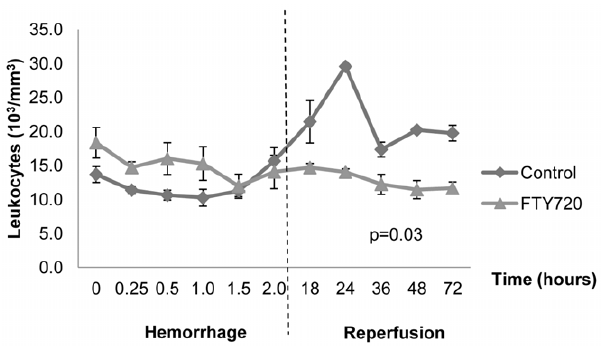
Figure 4. Peripheral leukocyte counts during hemorrhage and reperfusion periods. Dashed line indicates end of hemorrhage and beginning of reperfusion period. Leukocytes were significantly de- creased during the reperfusion period in the FTY720 group (p=0.03). Data is depicted as mean 6